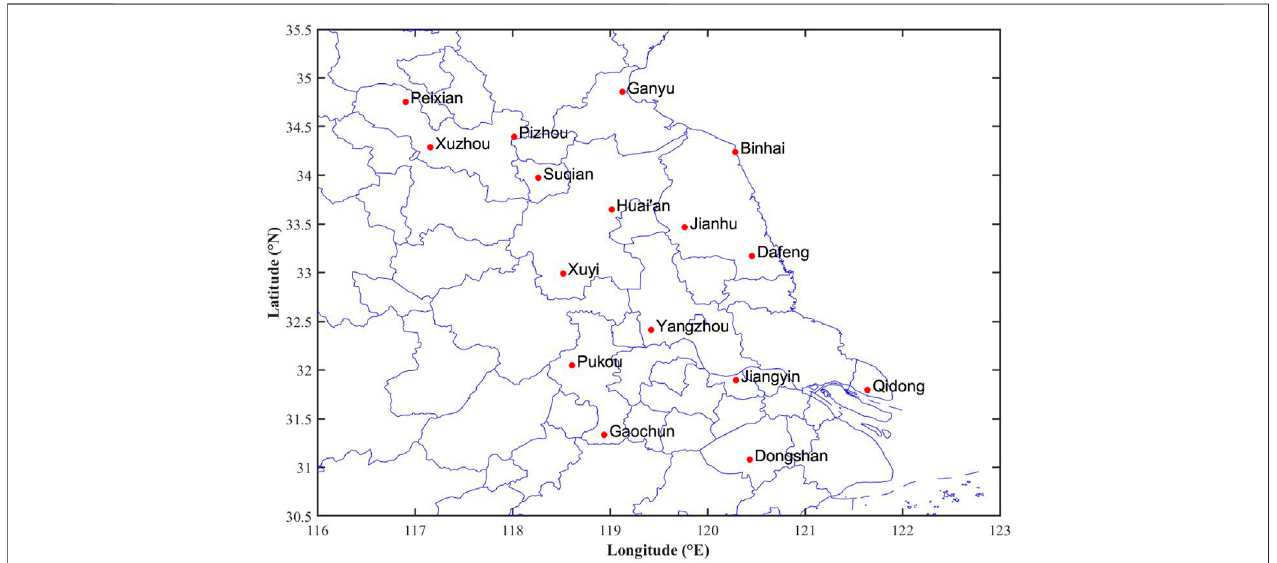
FIGURE 1 | Site distribution of ADTD-II lightning positioning